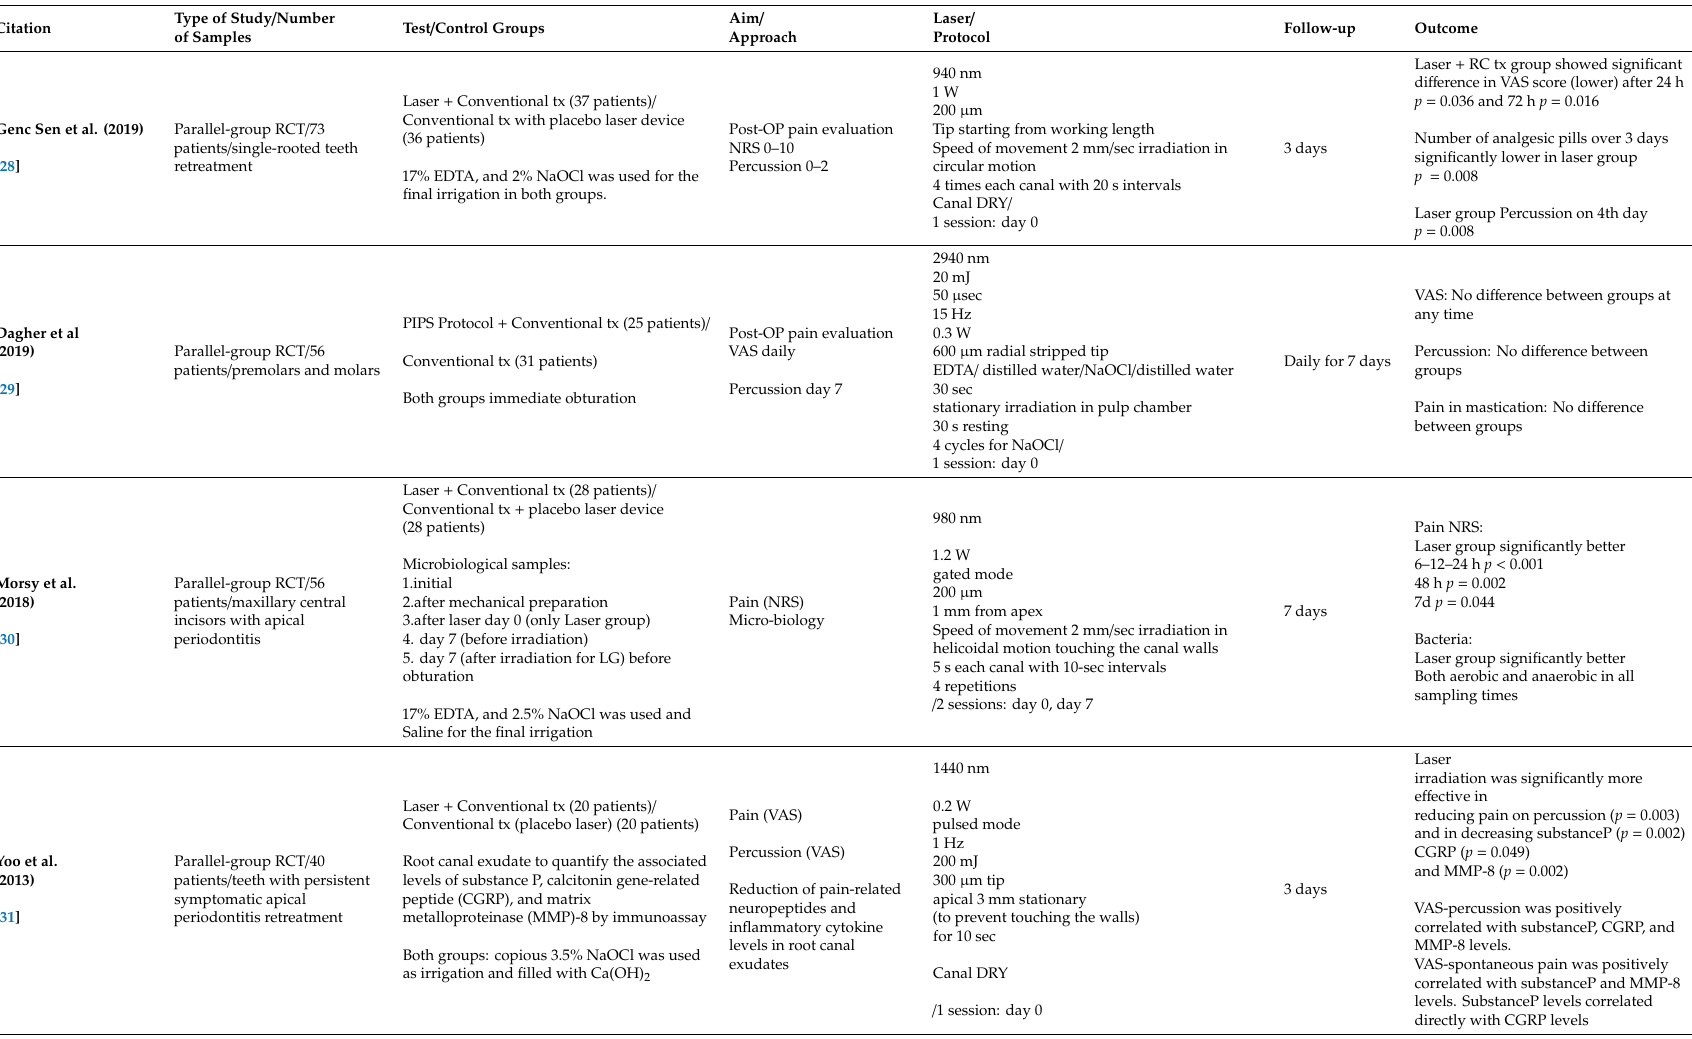
Table 1. Conventional laser-assisted endodontics. Key: Tx = treatment, VAS = visual analog scale, rc = root